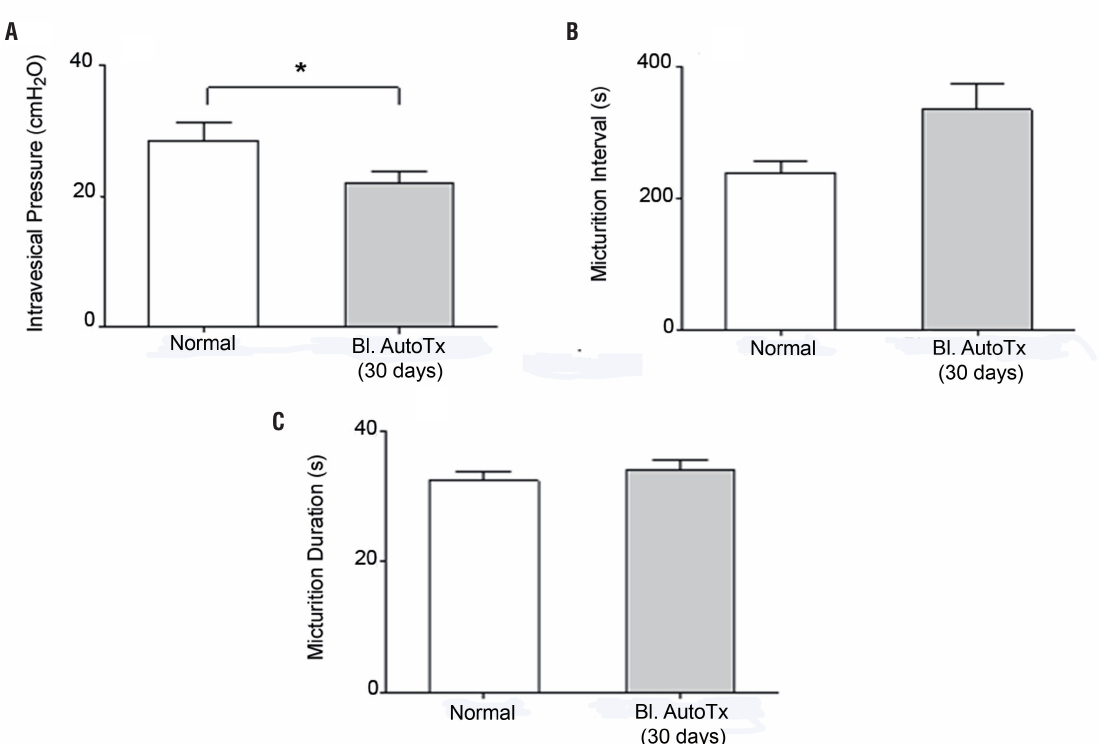
Figure 3 – Cystometric recordings of female Wistar rats which underwent bladder autotransplant performed 30 days after surgery. Evaluation of the maximal pressure amplitude of the bladder (A), micturition interval (B) and micturition duration (C). Flow rate of bladder perfusion (0.9% saline solution) was 0.08 ml/min (at 37ºC).